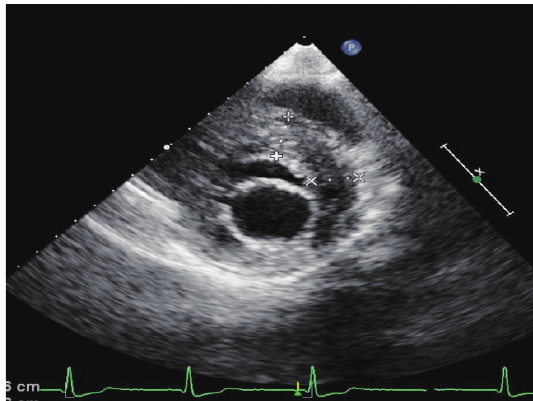
Figure 4 Left ventricular short axis view: Left ventricular anterior wall and anterior lateral wall are significantly thickened, with thicknesses of 19 mm and 18 mm,